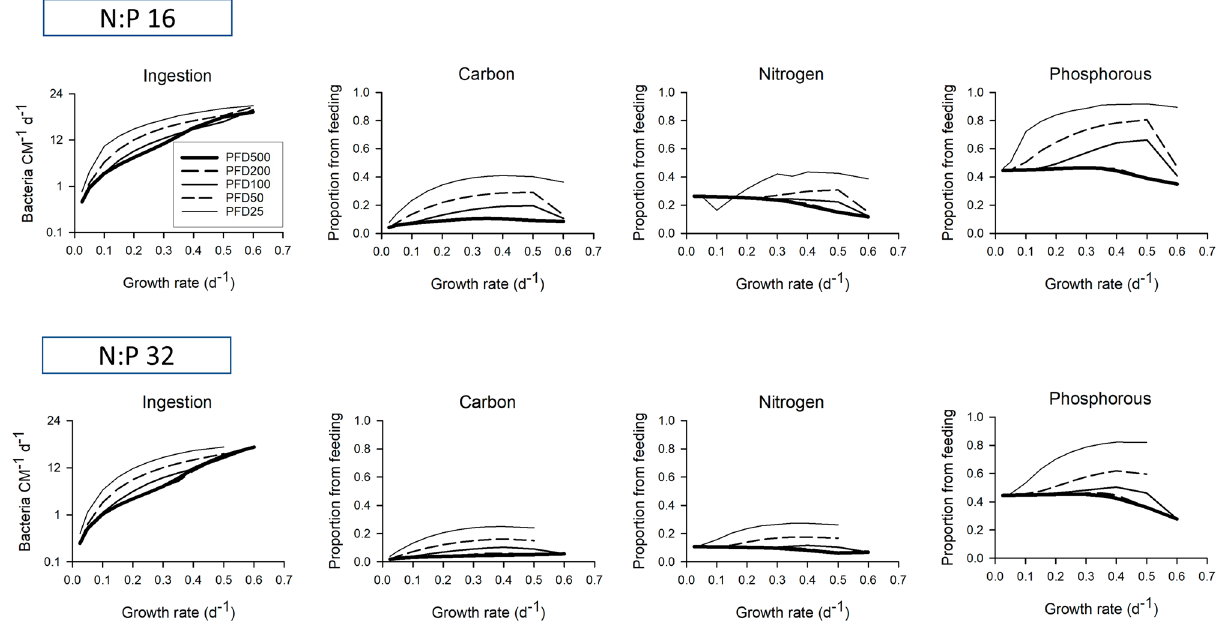
Figure 5. Ingestion rates and fate of ingested bacterial C, N, P biomass during mixoplankton growth at different photon flux densities. The system contained a total resource of 70 mgN m −3 , at a mole N:P = 16 or 32, with 20% P supplied as bacteria-P. The growth rate equates to the chemostat dilution rate at steady-state. Photon flux densities (PFD) are provided as µmol photon m −2 s −1 ; output values for PFD200 and PFD500 are almost the same, as photosynthesis is saturated ≥ 200 µmol photon m −2 s −1 . High rates of growth at some combinations of N:P and light could not be achieved. See also Figs. S7,